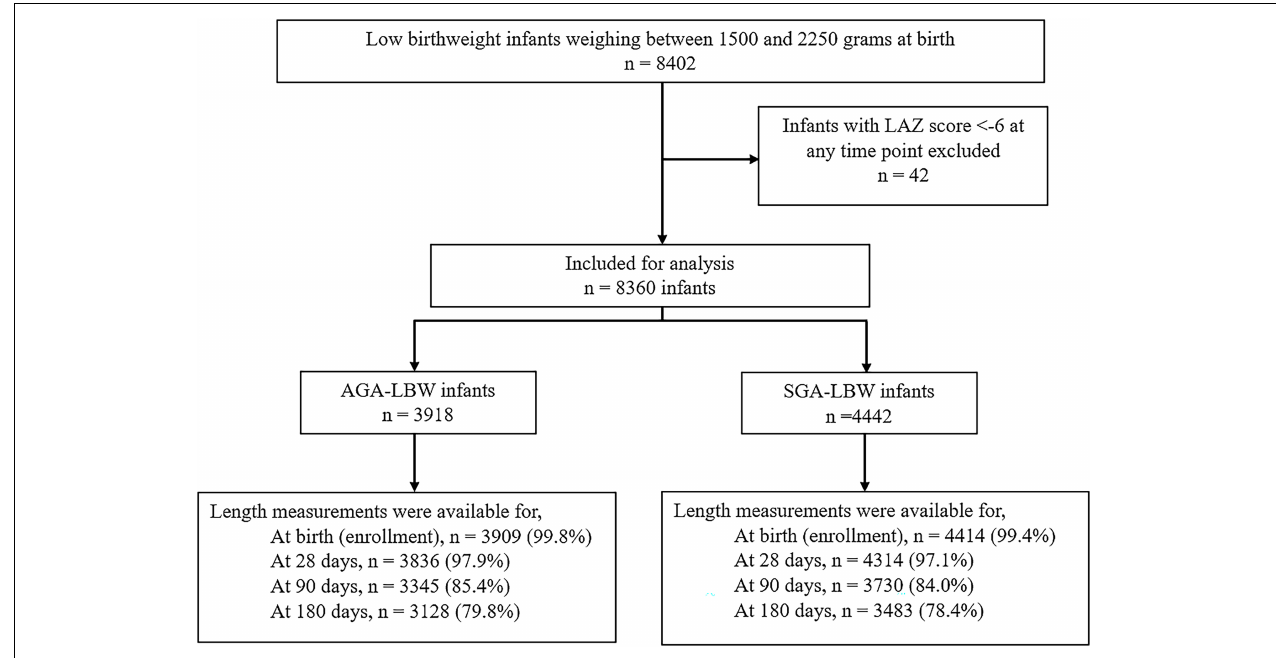
FIGURE 1 | Flowchart showing the number of infants with length measurements included in the analysis.